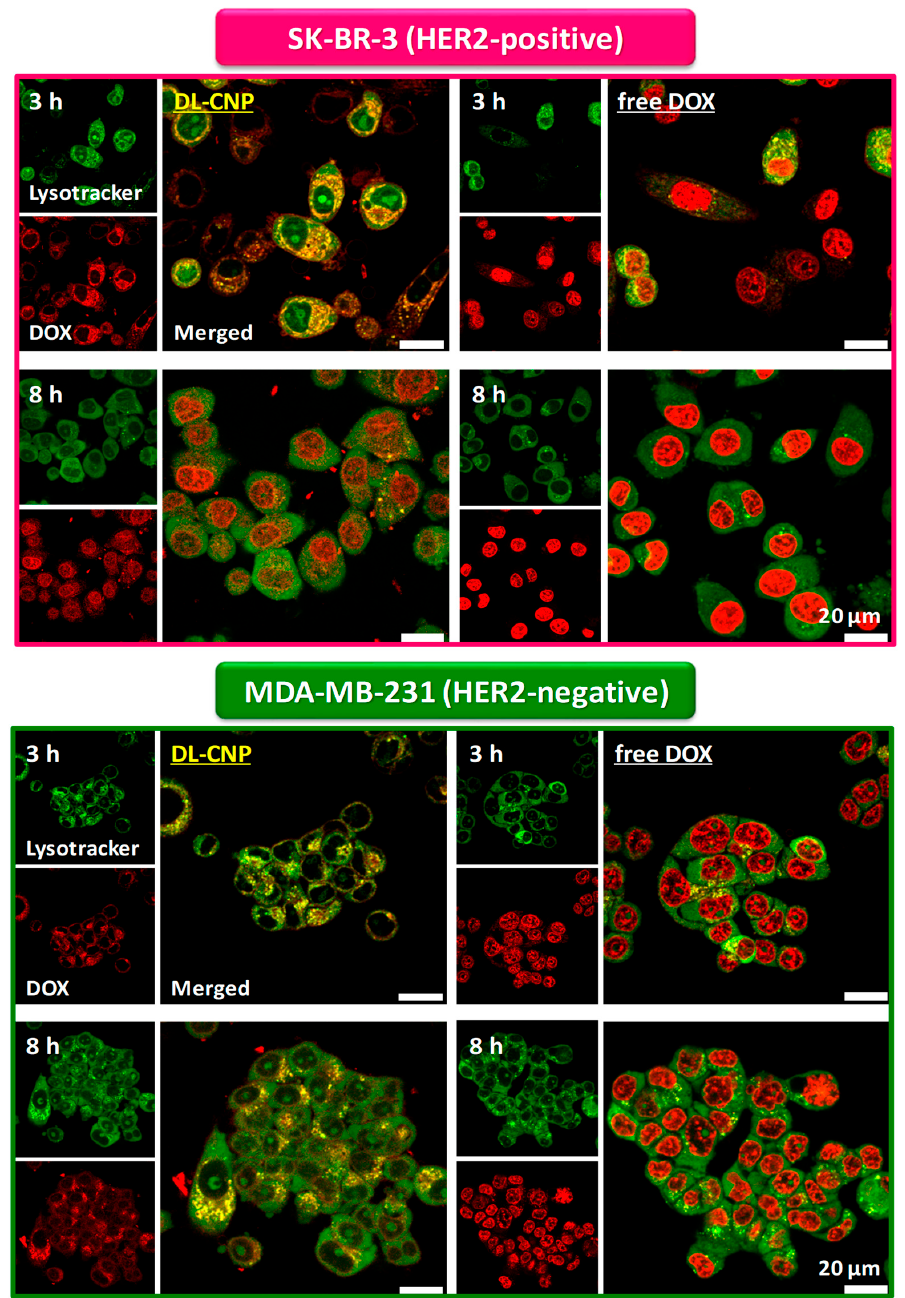
Figure 4. Confocal laser scanning microscopy (CLSM) images (scale bar = 20 µ m) of SK-BR-3 and MDA-MB-231 cells incubated with DL-CNPs and free DOX for 3 and 8